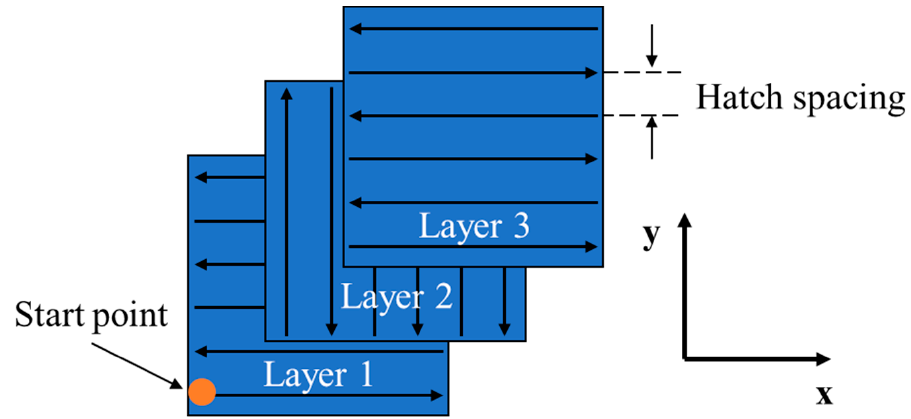
Figure 3. Illustration of the 90° rotation scanning strategy applied (adapted from [13,15]).